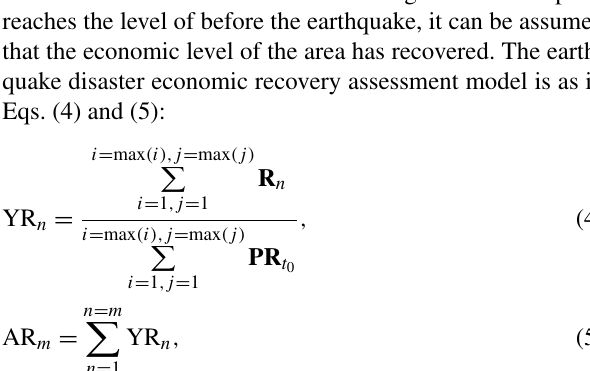
Figure 4. Correlation coefficient between GDP and DN-related pa-